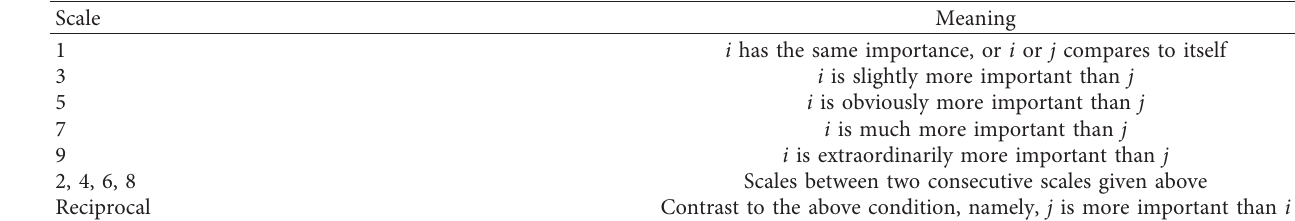
Table 1: Meaning of 1–9 scales.